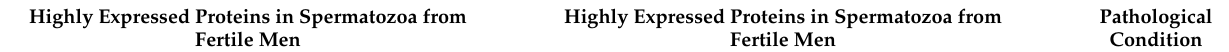
Table 3. Differentially expressed proteins in spermatozoa from fertile and infertile men according to their pathological